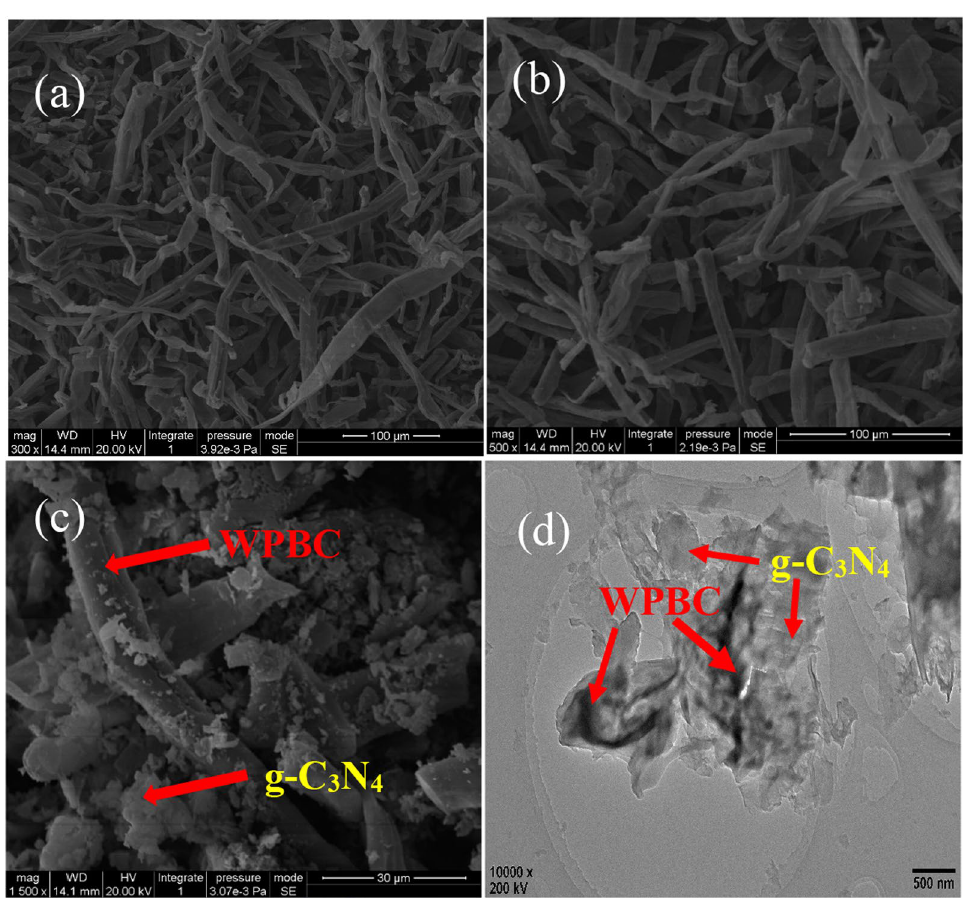
Fig. 1 SEM images of a WP, b WPBC, c WPBC 50 /g-C 3 N 4 , and d TEM image of WPBC 50 /g-C 3 N